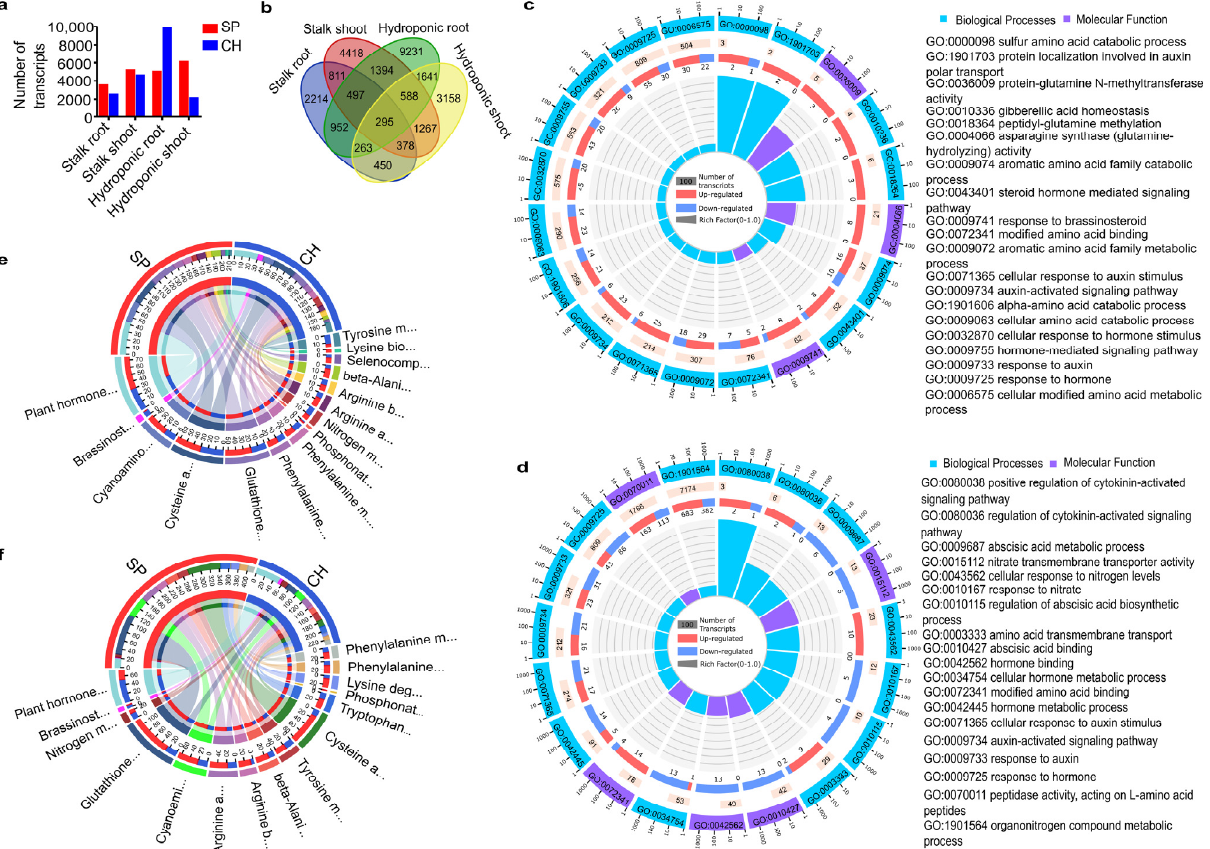
Figure 2. Quantitative evaluation of differentially expressed transcripts between BNF-contrasting genotypes. ( a ) The figure shows the number of differentially expressed transcripts that are more represented in each genotype for each condition. ( b ) Venn diagram shows the number of transcripts differentially expressed between SP and CH in each set (tissue and growth conditions). ( c , d ) Gene ontology (GO) enrichment analysis of DET in ( c ) stalk root and ( d ) stalk shoot. The first circle: the most enriched terms; outside the circle is the coordinated ruler of the number of transcripts. The second circle: the classification number in the background. The more transcripts, the longer the bar. The third circle: bar graph of the ratio of the DETs; red represents the ratio of the upregulated transcripts in SP, and blue represents it in CH. The fourth circle: The Rich Factor value of each category (the number of foreground transcripts in the category divided by the number of background transcripts). ( e , f ) The circus diagrams represent the KEGG pathway enrichment analysis of DETs in stalk root ( e ) and stalk shoot ( f ) of SP and CH. The figures show only the most significantly enriched GO terms and KEGG pathways that are involved in hormone, nitrogen, and amino acid pathways, such as: plant hormone—plant hormone signal transduction; Brassi-